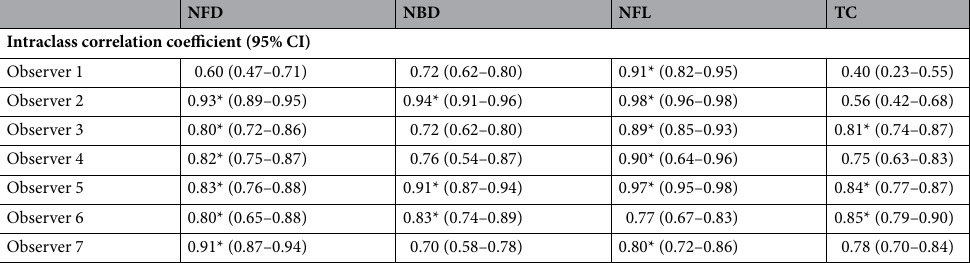
Table 2. The intraclass correlation coefficient for 2 CCMetrics (CCM) measurements separated by 2 weeks in all observers. NFD (nerve fiber density) is measured in number of fibers/mm 2 , NBD (nerve branch density) is measured in number of branch points on the main fibers/mm 2 , NFL (nerve fiber length) is measured in total length of fiber (mm/mm 2 ), TC (tortuosity coefficient) is measured in main fiber average tortuosity, CI confidence interval. *Represents an excellent correlation when values >